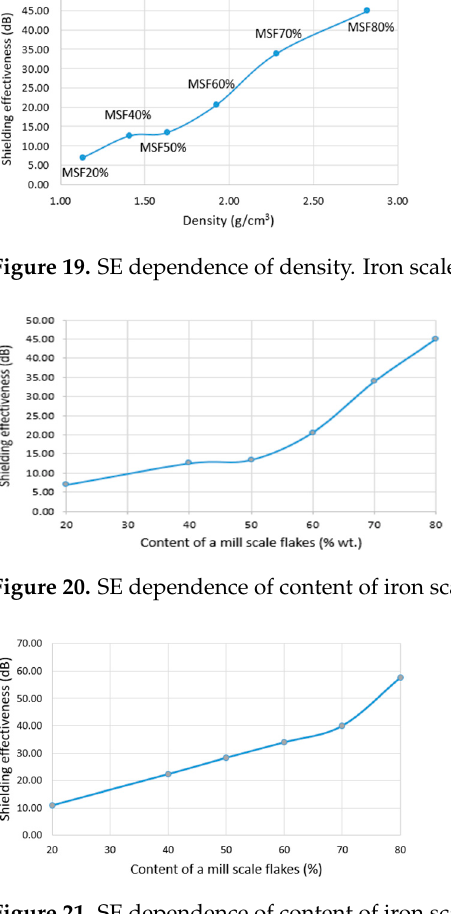
Figure 22. SE dependence of density. Iron scale powder. Frequency—10 GHz. Figure 23. SE dependence of content of iron scale powder. Frequency—10 GHz.